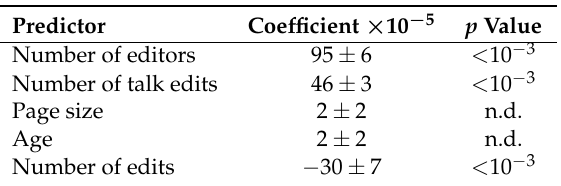
Table C.1. Coefficients of a multivariate linear regression for page eigenvector centrality (EC). The R 2 for the fit, including all predictors, is 0.57.